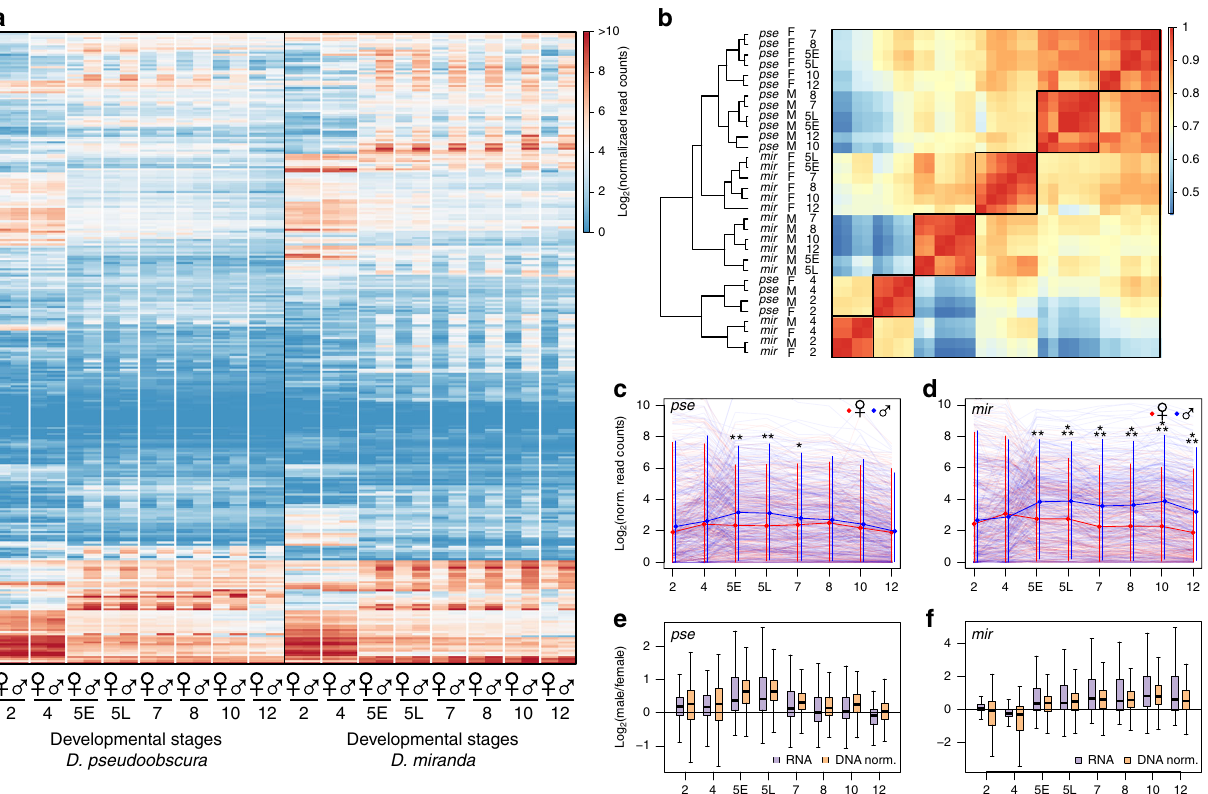
Fig. 2 Sex-speci fi c transcriptional regime of transposable elements across early embryogenesis. a Heatmap showing the normalized read counts mapping to TEs from developmentally staged and sexed embryos (average of three embryos) from D. pseudoobscura and D. miranda . The list of TE names can be found in Supplementary Fig. 1. For heatmap in FPKM, see Supplementary Fig. 2. b Heatmap depicting the correlation of TE transcript abundance between species, sex, and developmental stages. Samples were ordered by hierarchical clustering. c , d TE transcript abundance across developmental stages, and sexes in D. pseudoobscura and D. miranda . Light lines depict TE transcript abundance for individual TEs, and dark lines depict the median with 95% con fi dence intervals demarcated by vertical lines. *, **, and *** denote signi fi cant differences between males and females with p values of <0.01, <0.0001, and <0.000001, respectively (two-tailed Wilcoxon rank-sum test, n = 303 consensus TEs from the repeat index, no multiple testing correction). e , f Distribution of the fold differences in TE transcript abundance (purple) between sexes in log 2 scale. RNA-seq read counts at TEs are further normalized by their DNA-seq read counts to account for copy number, and the fold differences between sexes are depicted (orange); n = 303 consensus TEs from the repeat index. In the boxplots, whiskers delineate the minima and maxima of the distributions, the boxes demarcate the 25th and 75th percentiles, and the centers mark the medians. Source data are provided as a Source data fi